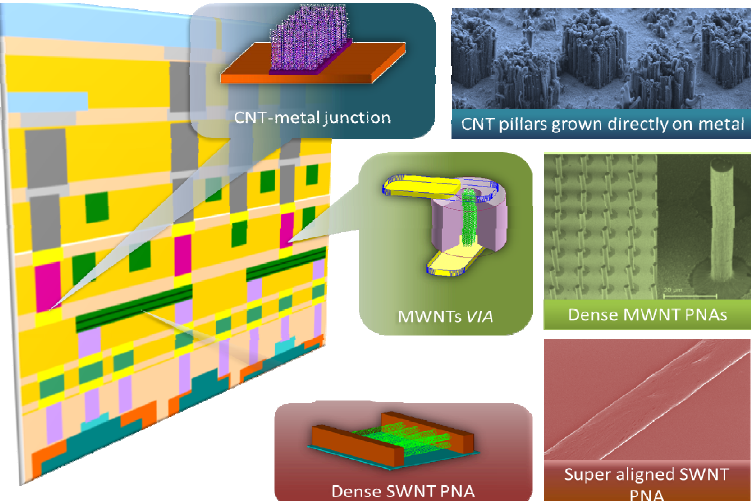
Figure 10. Schematic of a future Integrated Circuit (IC) chip with various interconnects potentially conceivable with CNT-based architectures, as described in the text which can hierarchically enable partial or full integrations in future IC chip